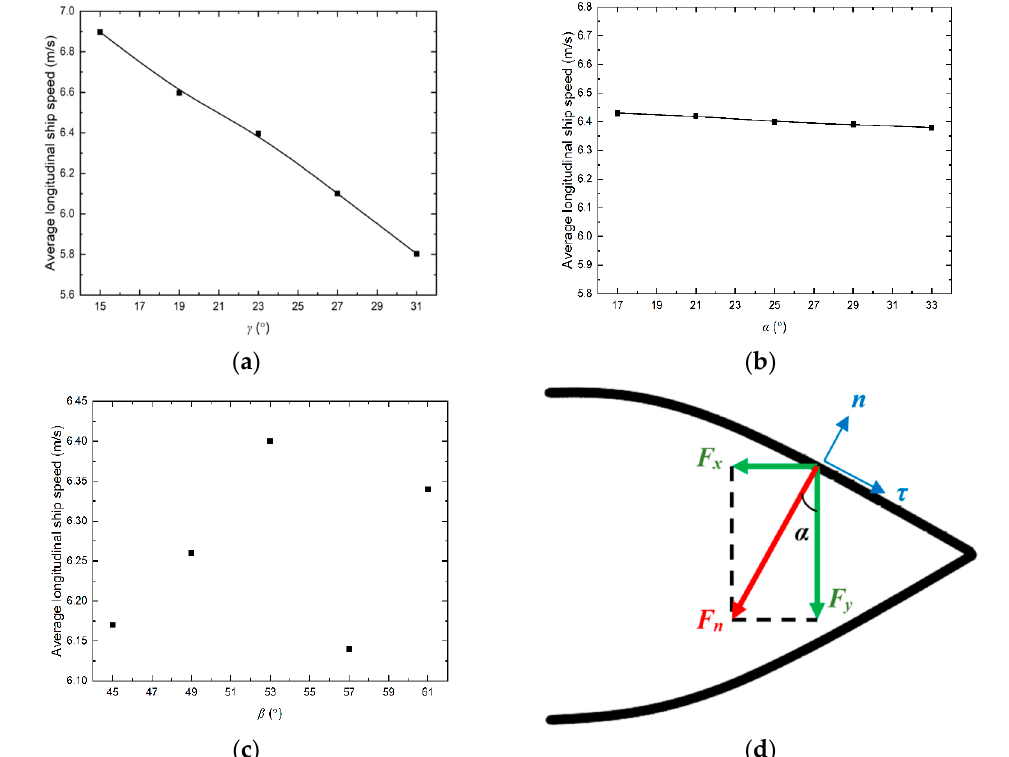
Figure 9. Average longitudinal ship speeds at different bow configuration parameters with ( a ) fixed α = 25° and β = 53°, ( b ) fixed γ = 23° and β = 53° and ( c ) fixed γ = 23° and α = 25°, respectively, and ( d ) illustrates the ice forces on the stem side.